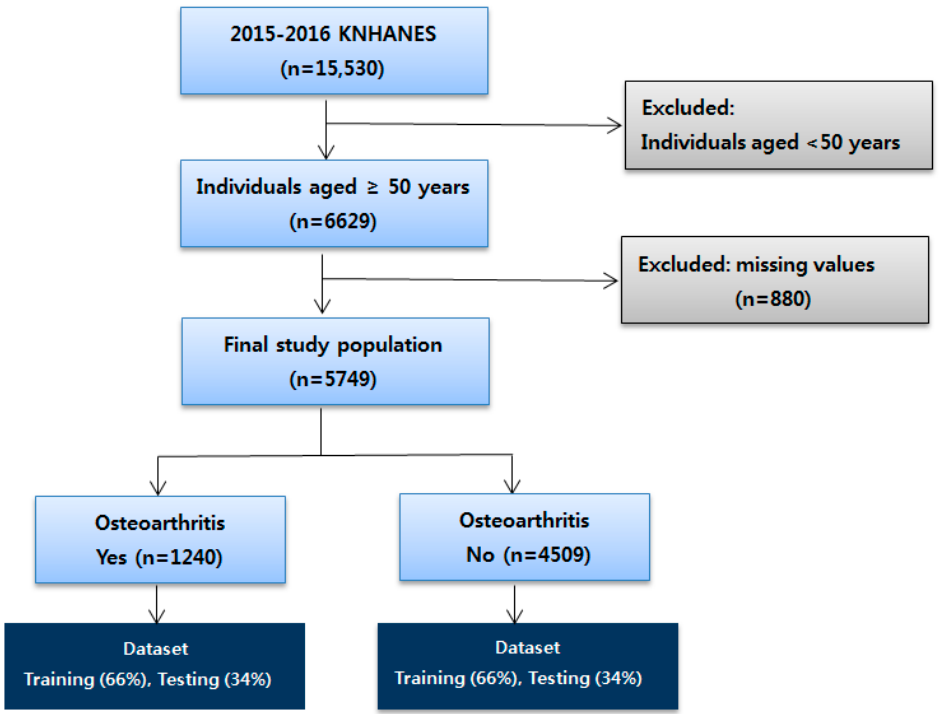
Figure 1. The selection process for the study population (KNHANES: Korea National Health and Nutrition Examination Survey).